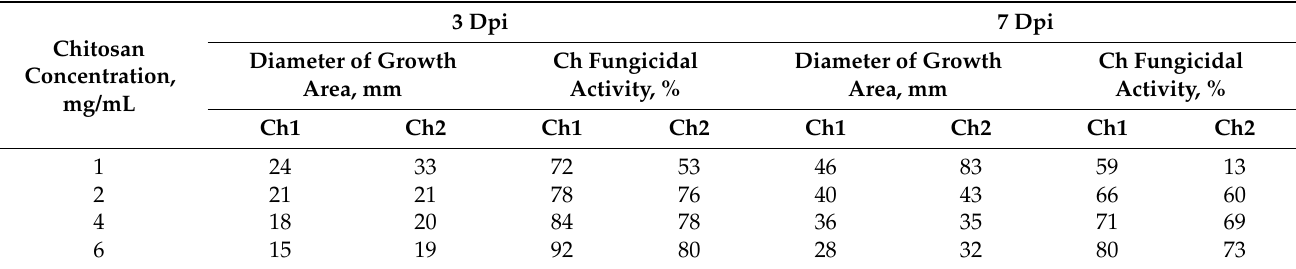
Table 2. Growth of F. proliferatum on Ch-containing